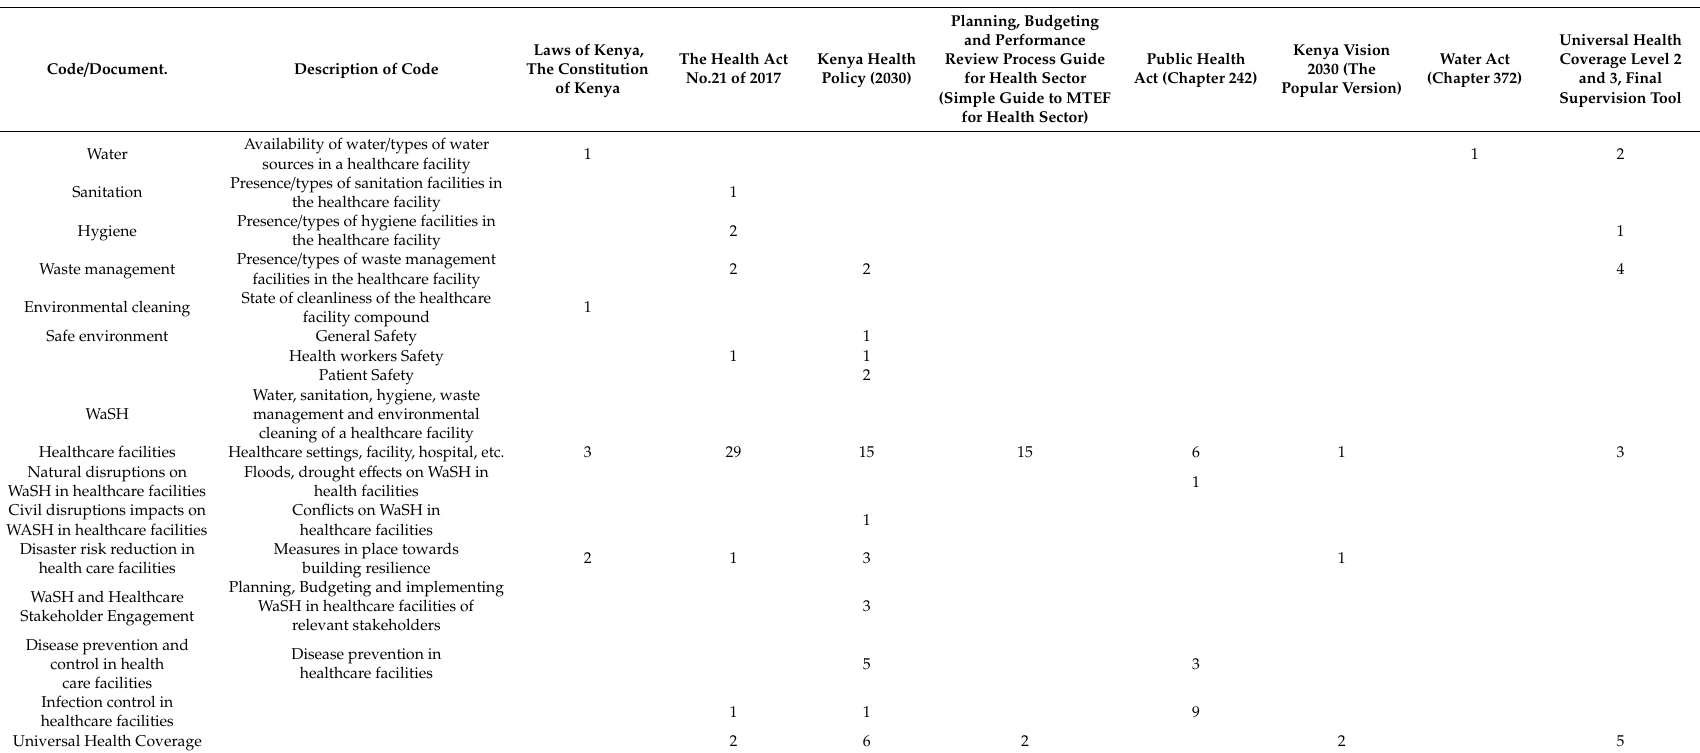
Table 4. Filled coding schedule for national-level